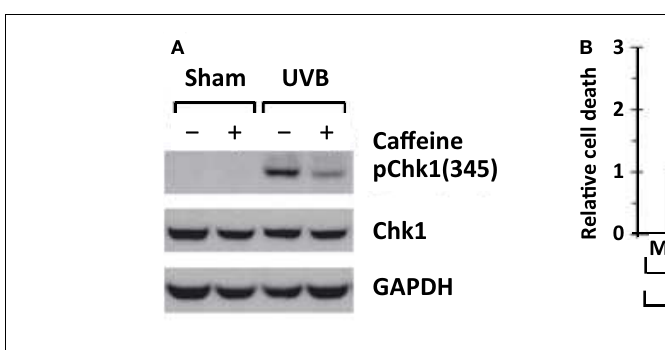
ATR or a non-targeting/scrambled control (scr). Forty-eight hours later, cells were exposed to 75mJ/cm 2 of UVB, and the cells were harvested 24h later. Relative cell death was calculated by comparing percentage of sub-2N DNA content in scr + caffeine/UVB-, siRNA for ATR + medium/UVB-, or siRNA for ATR + caffeine/UVB-treated cells with that in scr + medium/UVB-treated cells in each experiment. Average of relative cell death is shown ( n = 3). Error bar, standard error of the mean.Taken from Heffernan et al.